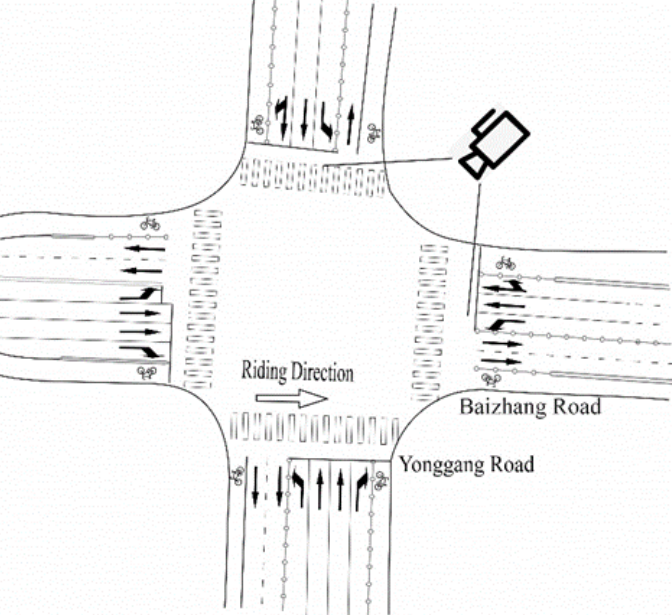
Figure 1. Setting details for observation. Table 2. Delay Model